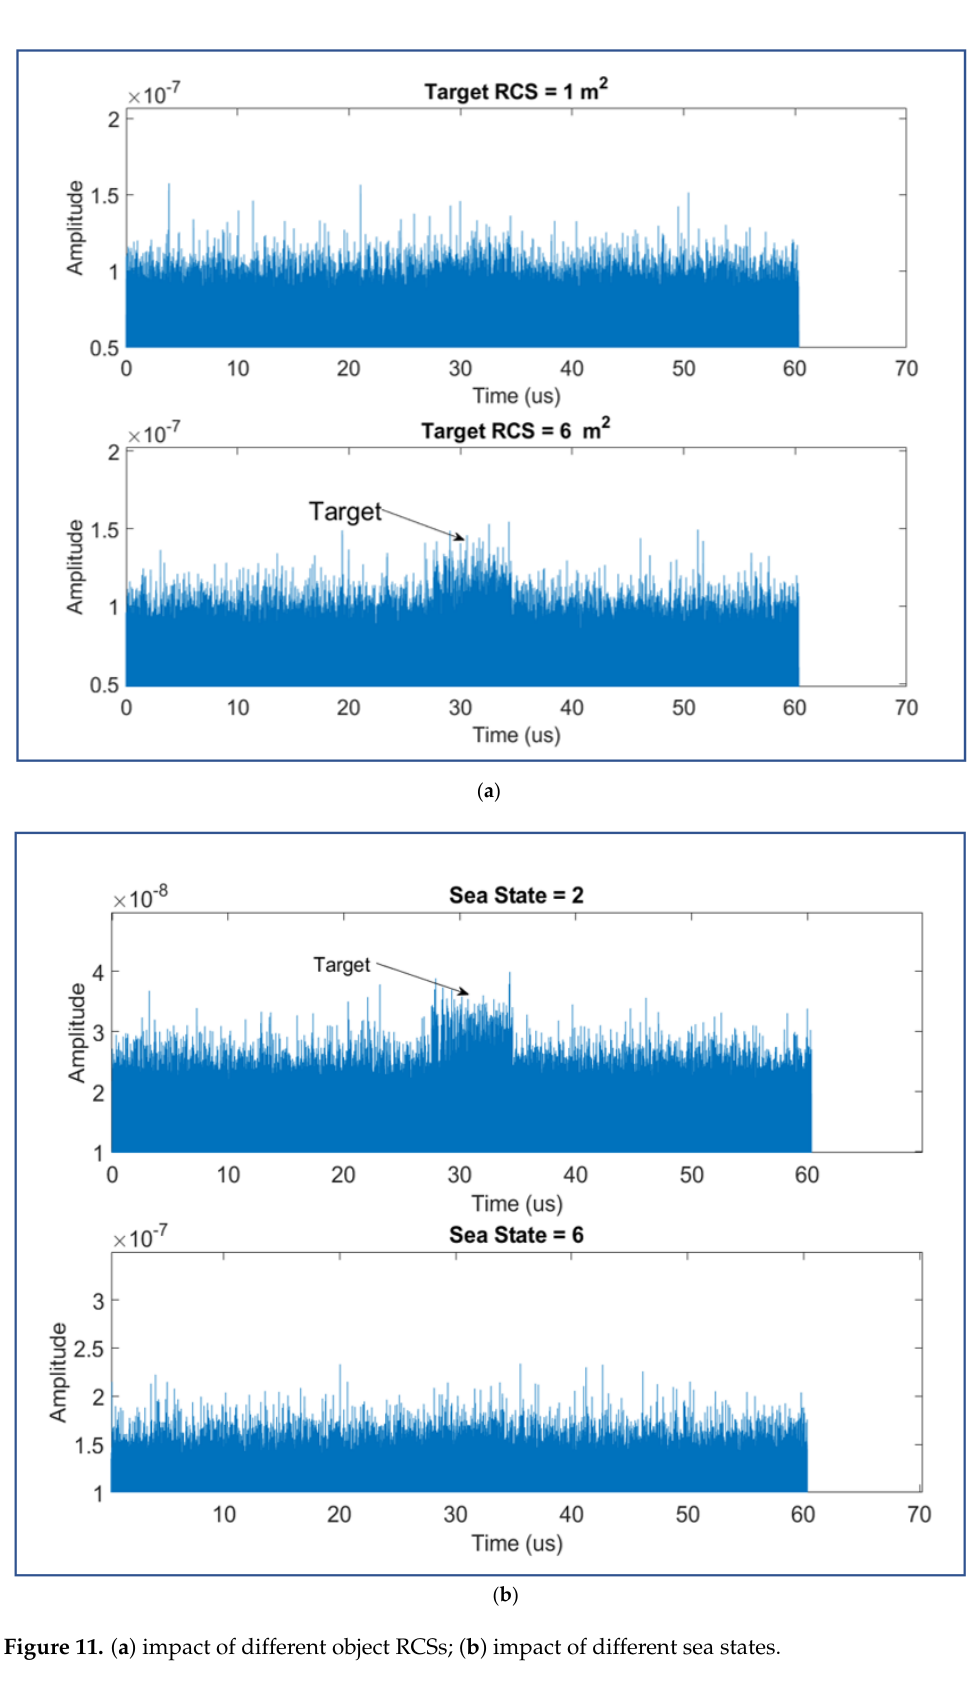
Figure 10. Simulation of signal-to-clutter ratio versus detection range.